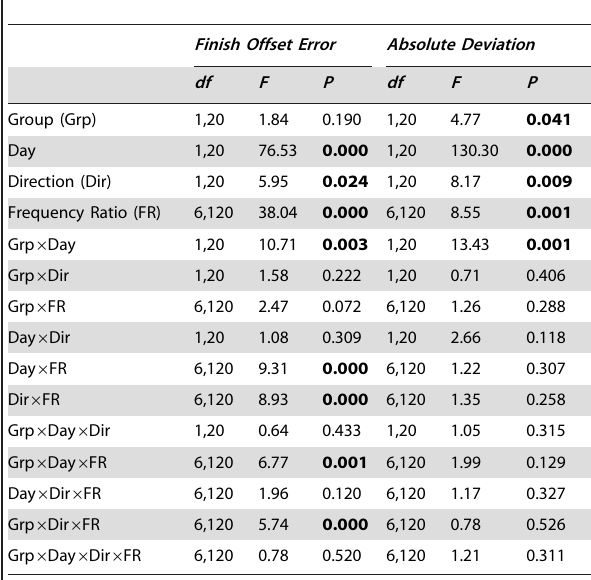
Table 1. Summary of ANOVA results on Finish Offset error and Absolute Deviation (2 6 2 6 2 6